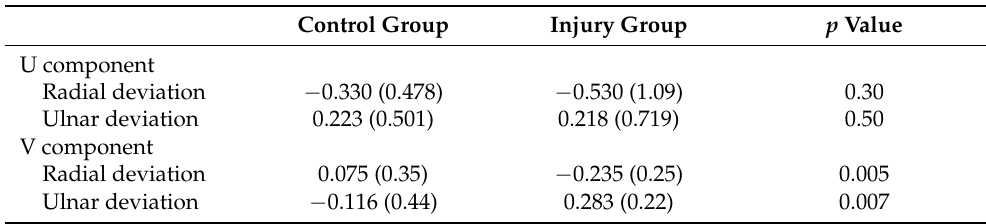
Table 2. The results of the U component and the V component.